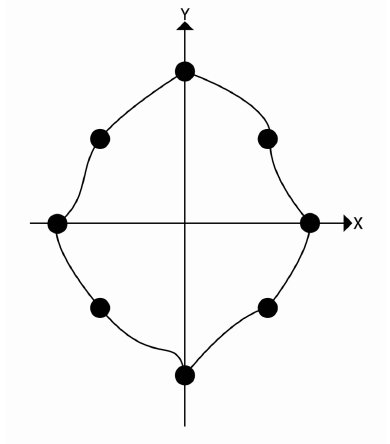
Figure 9. Outline of the model behavior in two